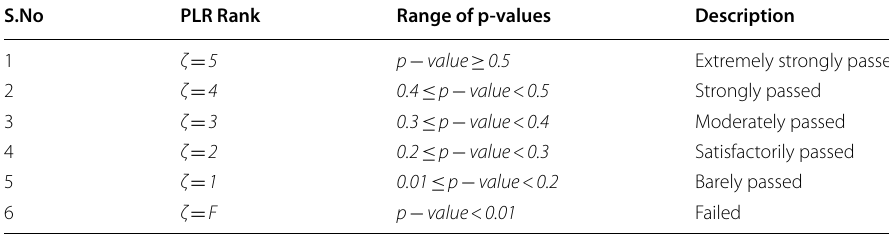
Table 2 Classification of p -values into PLR ranks S.No PLR